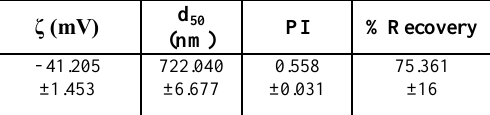
Table 4: Theophylline nanoparticles